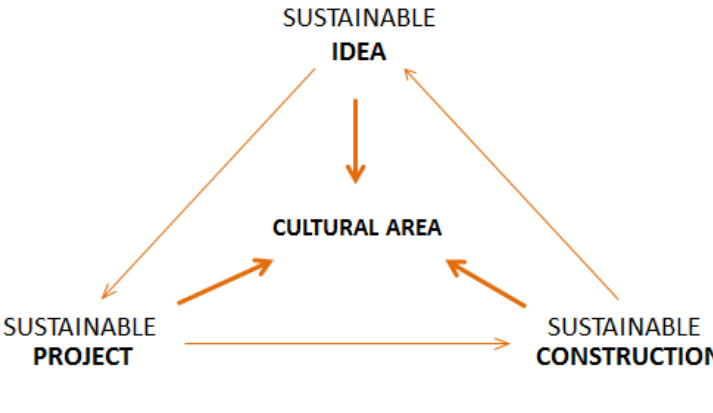
Figure 2. An a priori conception of